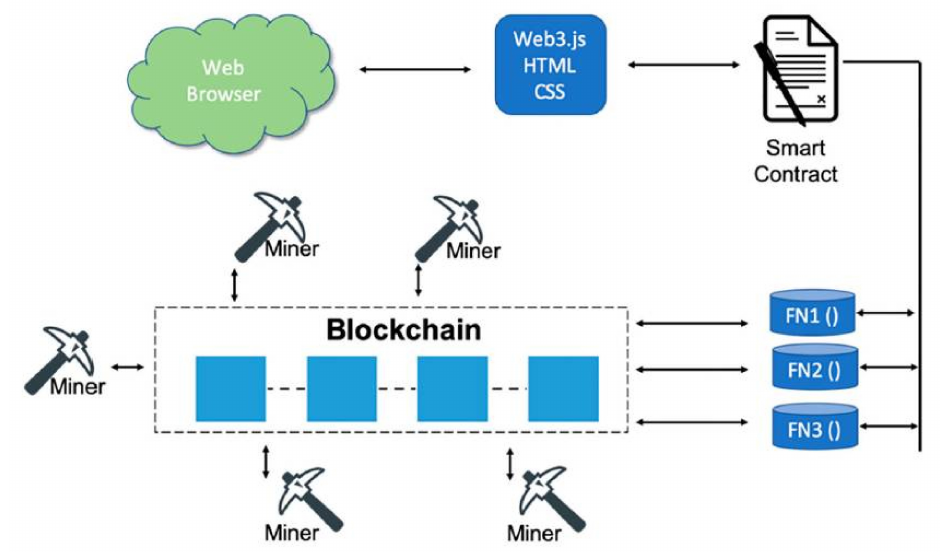
Figure 2. Cryptocurrency payment chain via Smart Contract. Source: